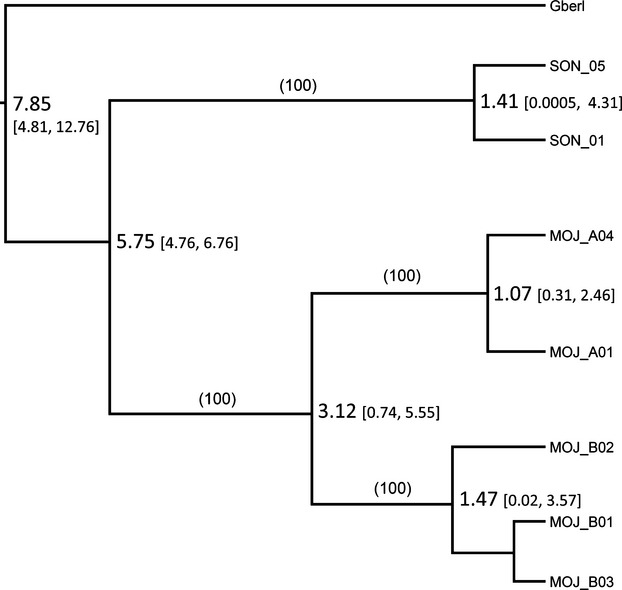
Genealogical reconstruction of mitochondrial haplotypes (ND3, arginine tRNA, ND4L, and part of ND4) rooted with G. berlandieri out-group. Nodes labeled with mean TMRCA as million years ago with brackets containing 95% highest posterior density intervals; generated using BEAST v1.7.5 (Drummond and Rambaut 2007). 50% majority-rule consensus tree bootstrap values in parentheses.